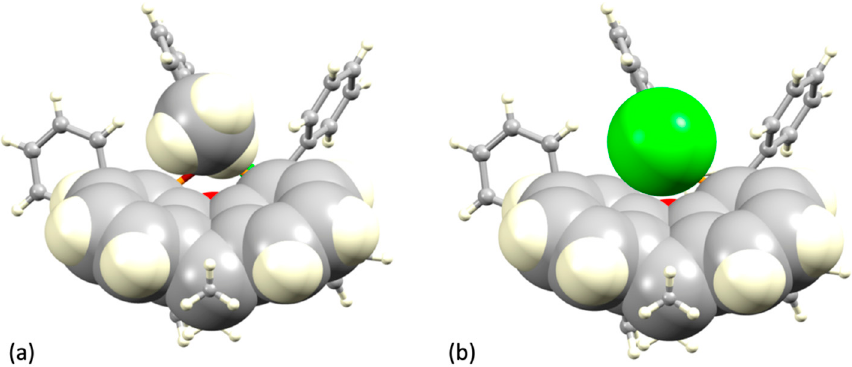
Figure 4. Hosting of the ( a ) methyl or ( b ) chloro substituent in the xanthene ‘bowl’ in [Cu(xantphos)(6-Cl-6’-Mebpy)][PF 6 ]. The structures are drawn using the two equal occupancy coordinates of the 6-Cl-6’-Mebpy ligand.